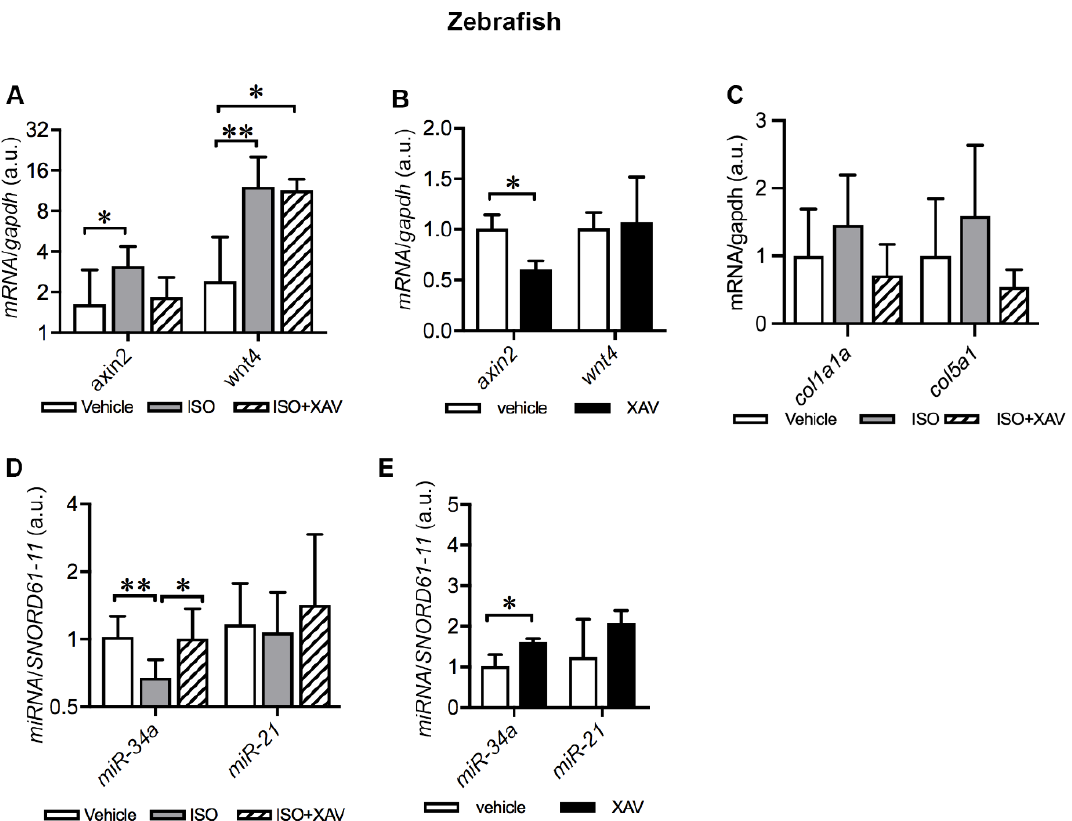
Figure 8. Tnks inhibition amends dysregulation of cardiac Wnt signaling and miRNAs induced by ISO in adult zebrafish. ( A ) qRT-PCR analysis of axin2 and wnt4 expression in zebrafish hearts treated with ISO alone or together with XAV939 compared to the vehicle. ( B ) qRT-PCR analysis of axin2 and wnt4 expression in zebrafish hearts treated with XAV939 compared to the vehicle. ( C ) qRT-PCR analysis of col1a1a and col5a1 expression in zebrafish hearts treated with ISO alone or together with XAV939 compared to the vehicle. ( D ) qRT-PCR analysis of the expression of selected miRNAs in zebrafish hearts treated with ISO alone or together with XAV9393 compared to the vehicle. ( E ) qRT-PCR analysis of the expression of the selected miRNAs in zebrafish hearts treated with XAV939 compared to the vehicle. The graphs represent the quantification of two individual analyses of RNA extracts from pooling samples of three hearts. Each analysis includes three replicates. ( A , C , D ): vehicle, n = 18 hearts; ISO, n = 18 hearts; ISO+XAV939, n = 10 hearts. ( B , E ): vehicle, n = 10 hearts; XAV939, n = 10 hearts. Data are presented as mean ± SD. One-way ANOVA with Tukey adjustment for multiple comparisons ( A , C , D ). Two-sample t -test ( B , E ): * p < 0.05, ** p < 0.01.